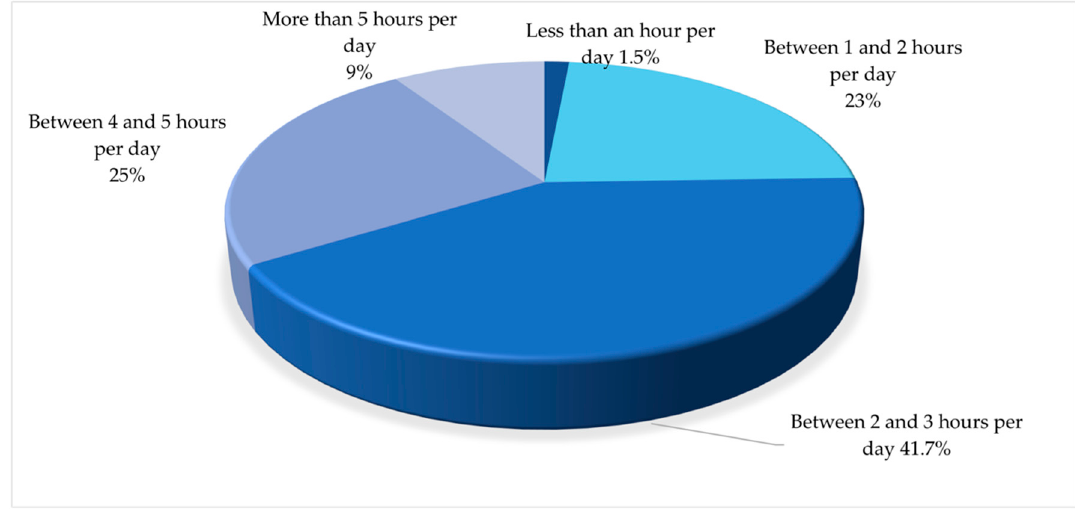
Figure 4. Graphical representation average time spend in social networks per day. Own elaboration.